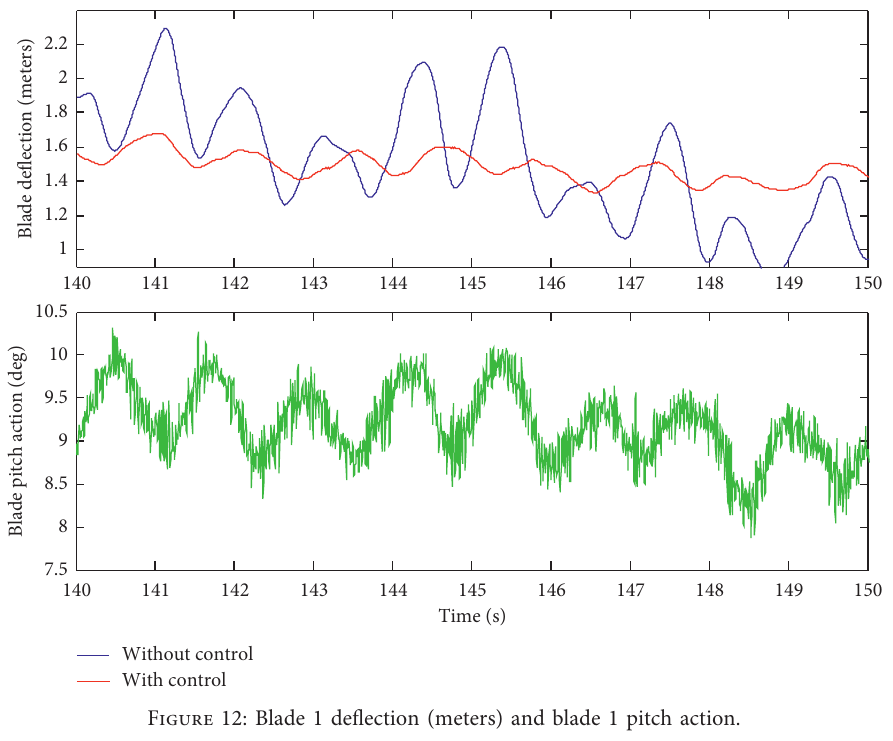
Figure 12: Blade 1 deflection (meters) and blade 1 pitch action.